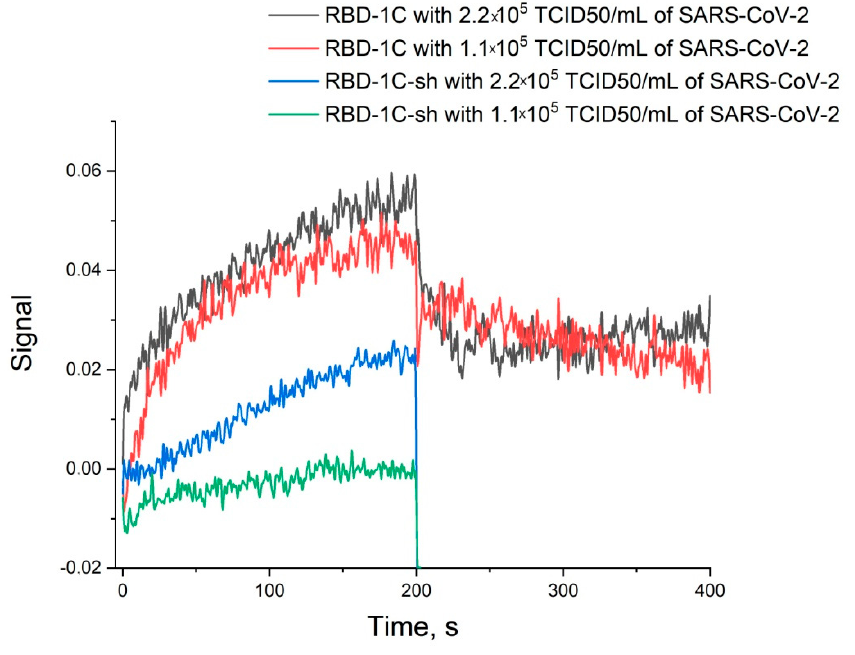
Figure 3. Sensorgrams of the interaction between SARS-CoV-2 viruses and immobilized oligonu- cleotides RBD-1C and RBD-1C-sh. The concentrations of the virus are provided.